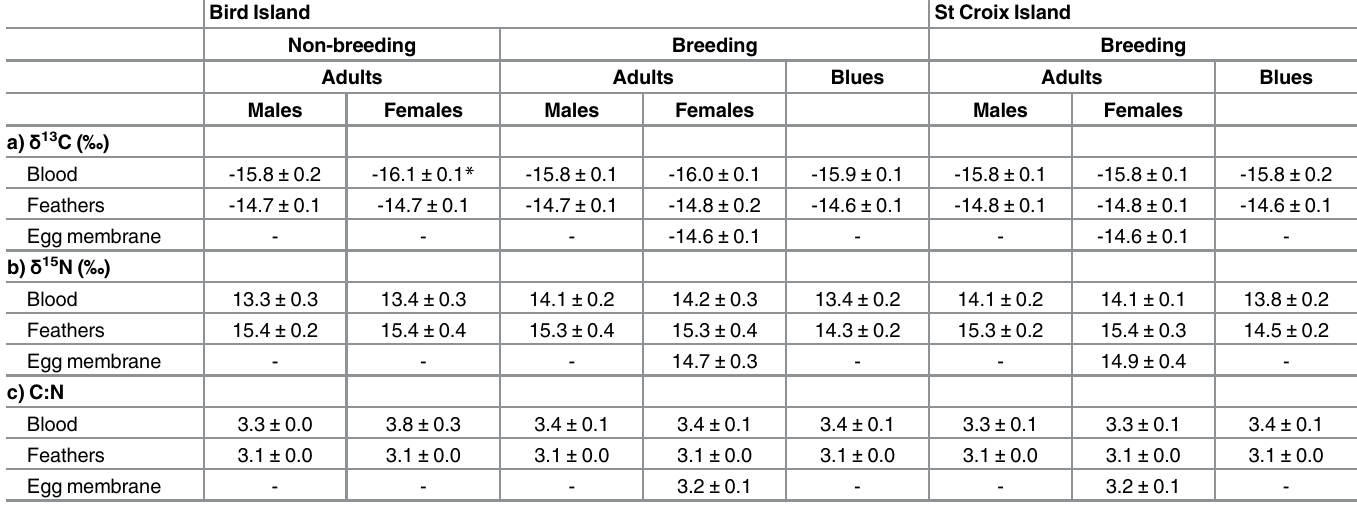
Table 2. Carbon (a) and nitrogen (b) stable isotope ( ‰ ), and C:N ratio (c) values of blood, feathers and egg membranes of African penguins breed- ing in Algoa Bay. Bird